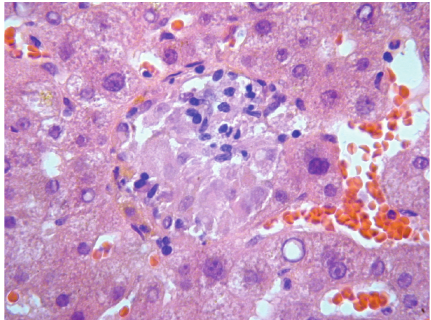
Figure 1: Liver biopsy showing hepatic granuloma.